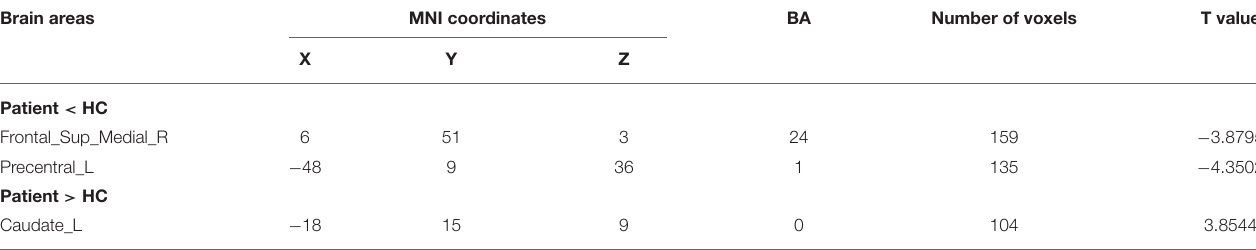
TABLE 2 | Brain areas with significantly different AF values between patients with MMD and HCs. Brain areas